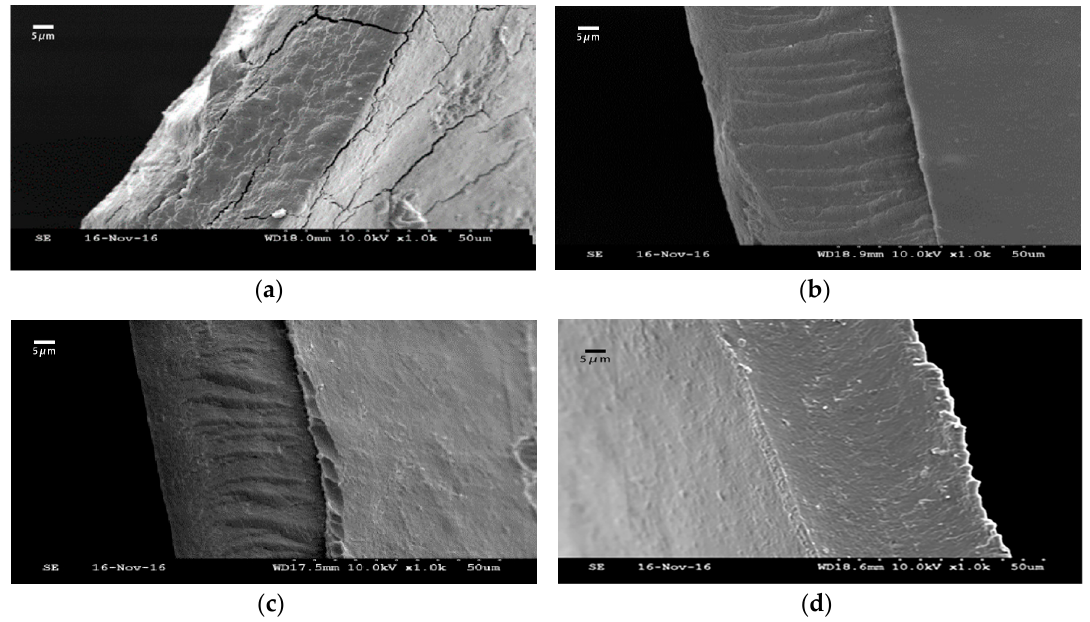
Figure 2. SEM images of composite films with tea polyphenol contents of ( a ) 0%; ( b ) 0.6%; ( c ) 1.8%, and ( d ) 3.0%.